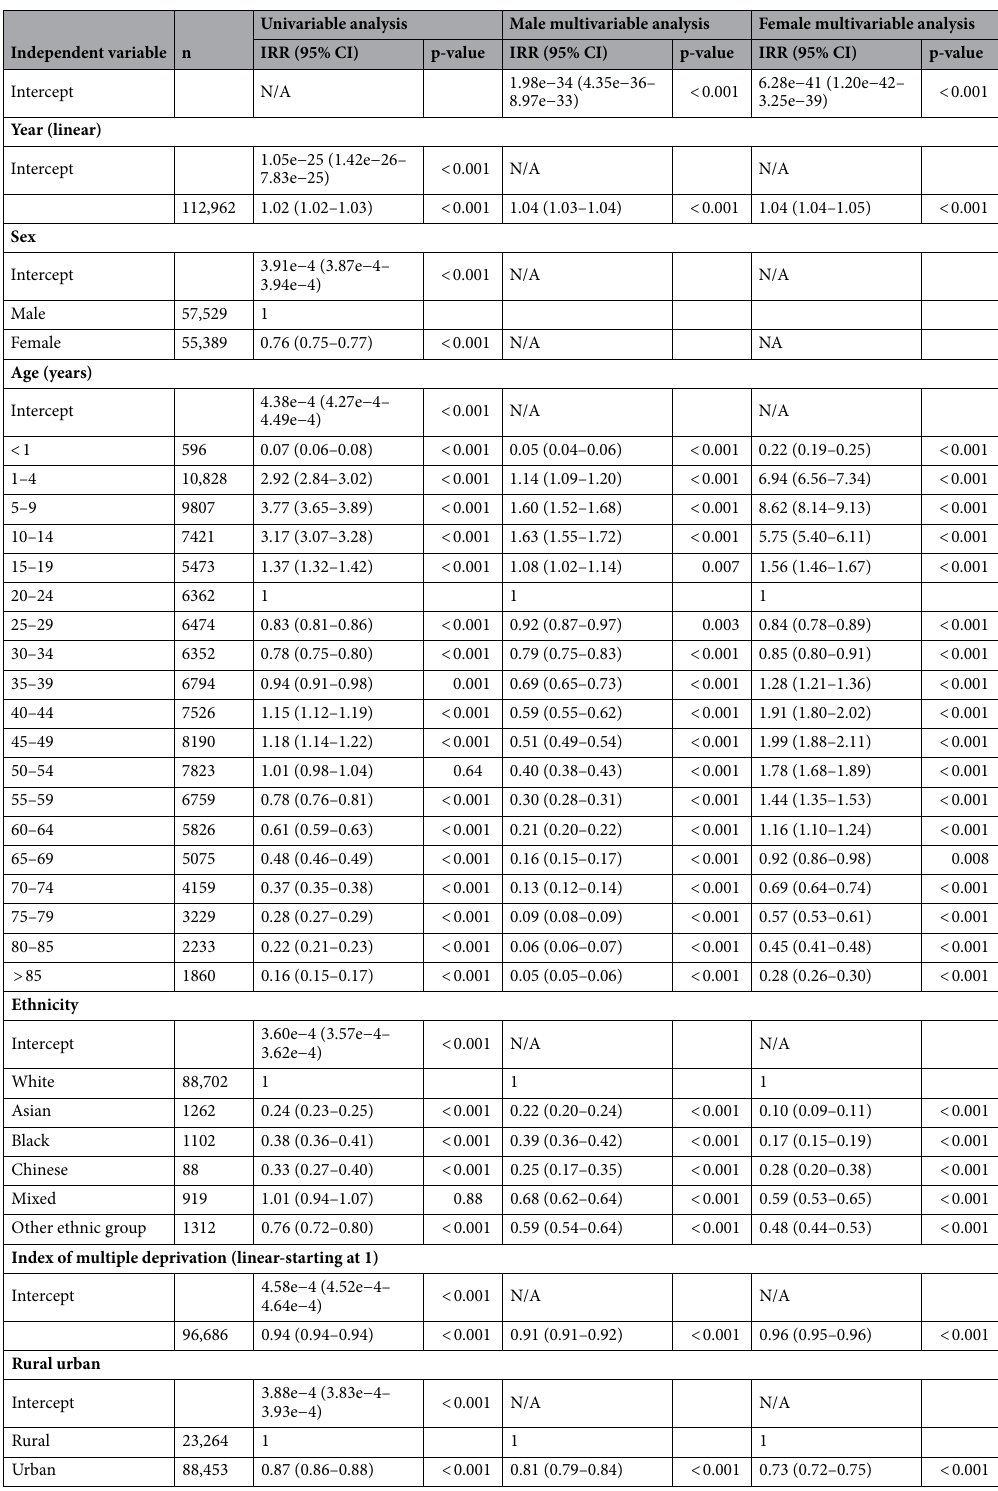
Table 2. Univariate and multivariable Poisson regression analysis for dog bite admission in English hospitals. IRR incidence rate ratio, CI confidence